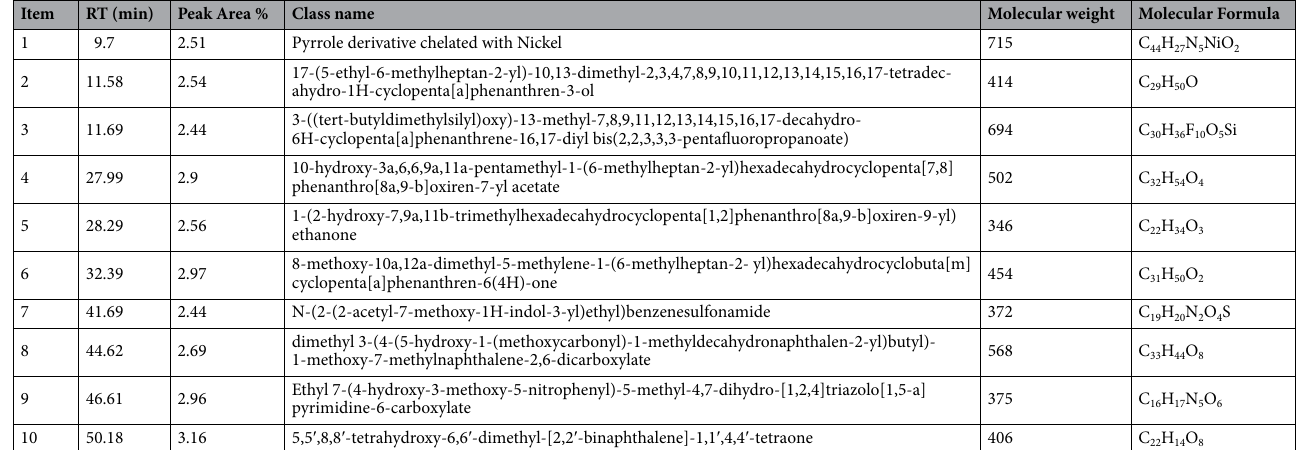
Table 3. Compounds identified by Gas Chromatography-Mass Spectrometry (GC.MS) in ethanolic extract of Thymus vulgaris .